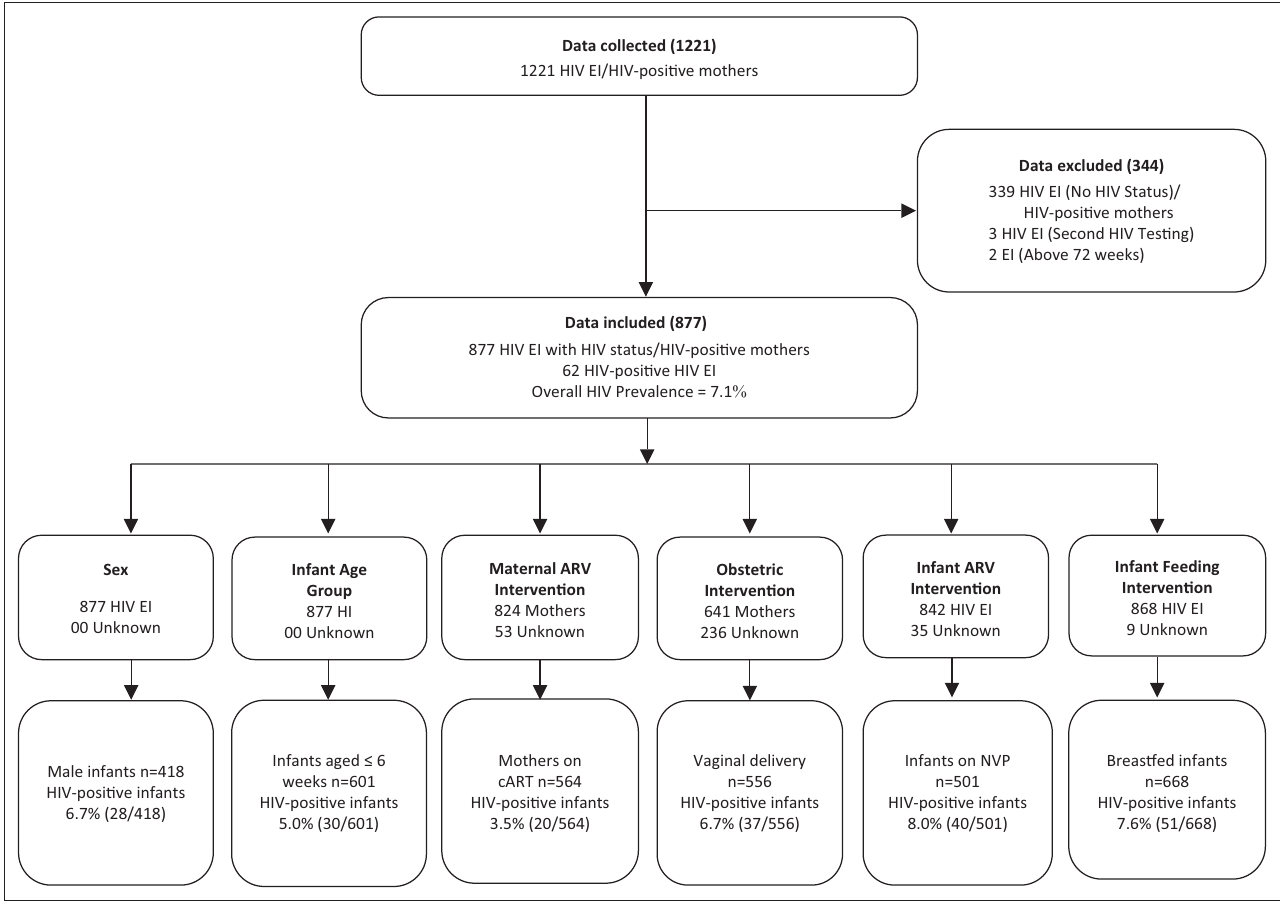
FIGURE 1: Flow Chart of representation of the population used to estimate the Prevalence of HIV in HIV exposed infants in the Regional Hospital Bamenda.